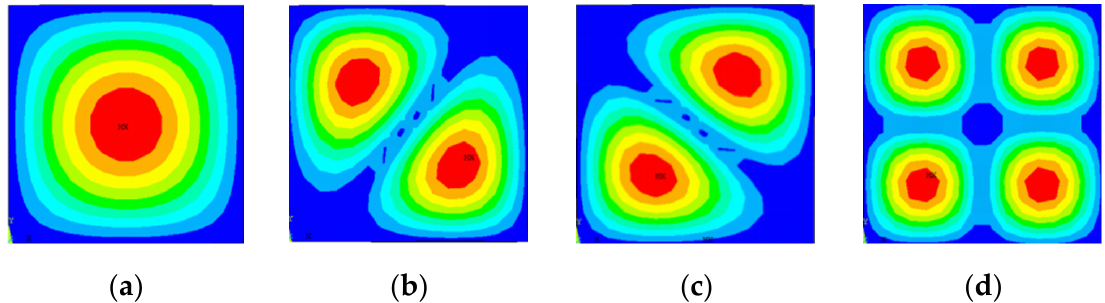
Figure 4. The first four-order vibration mode of ANSYS. ( a ) First order vibration mode, ( b ) Second order vibration mode, ( c ) third order vibration mode, and ( d ) fourth order vibration mode.